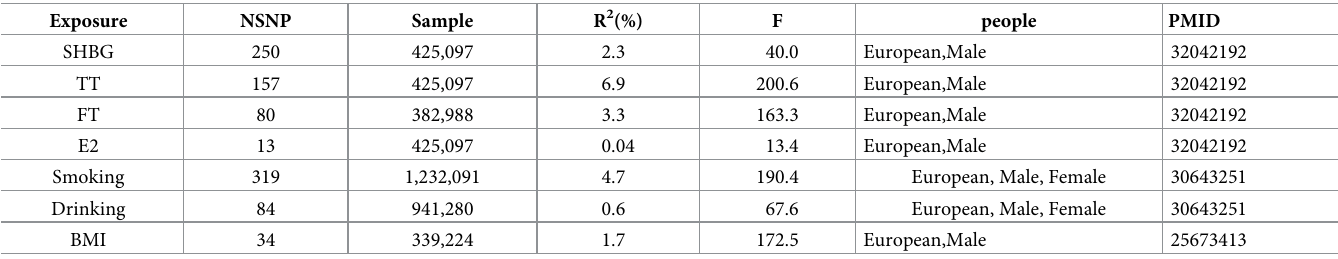
Table 1. Summary of risk